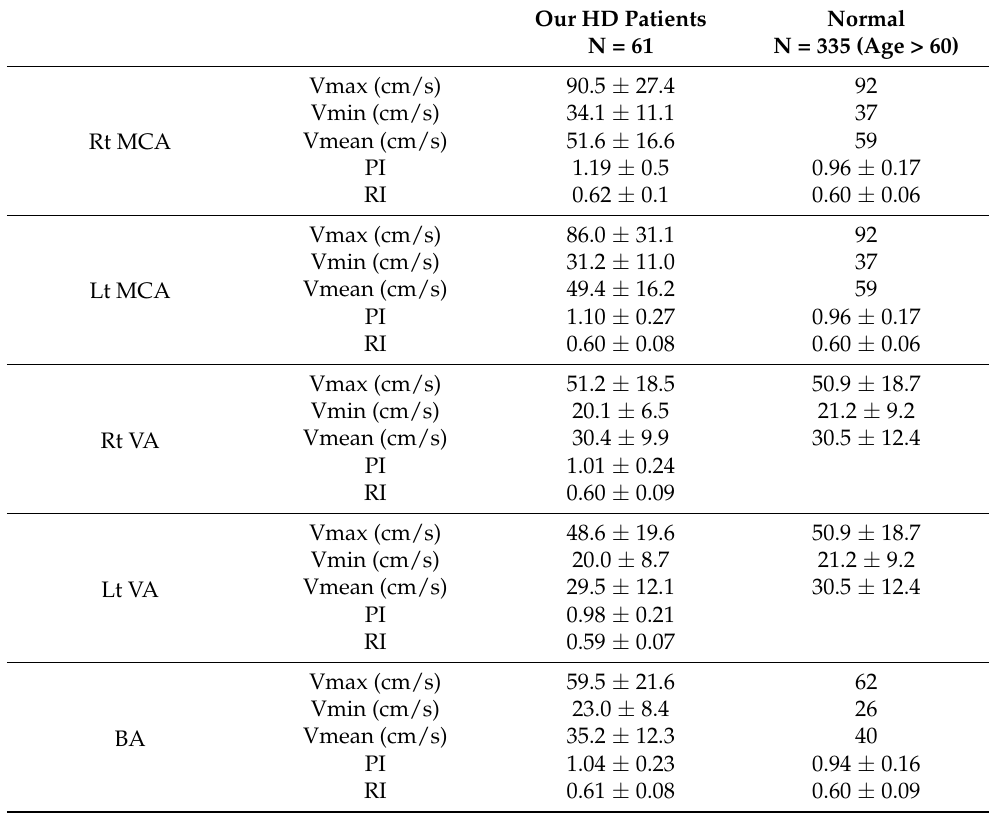
Table 3. Transcranial Doppler measurements of our HD patients and normal references